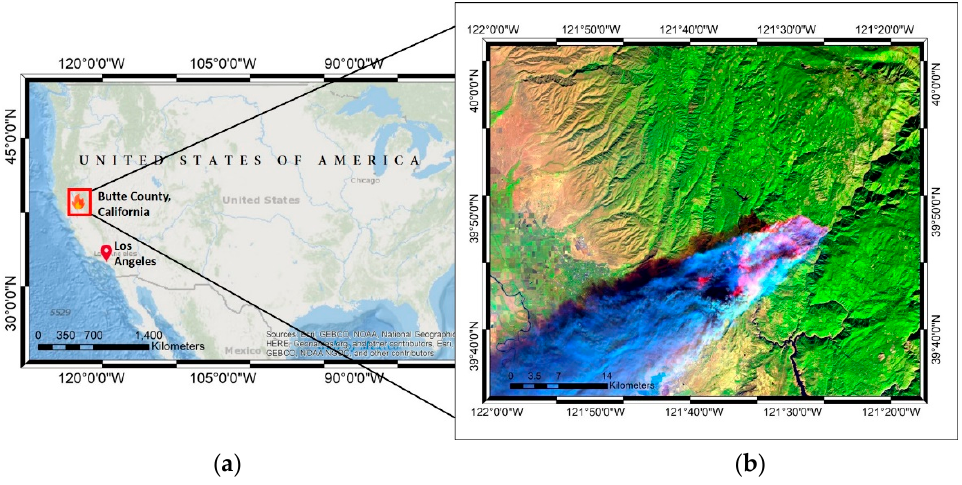
Figure 1. Maps of Butte County, California, United States of America, where the Camp Fire wildfire burned for 17 days, from November 8 to November 25: ( a ) location of Butte County in relation to the city of Los Angeles and ( b ) image of Butte County from Sentinel ‐ 2 data acquired on November 11,